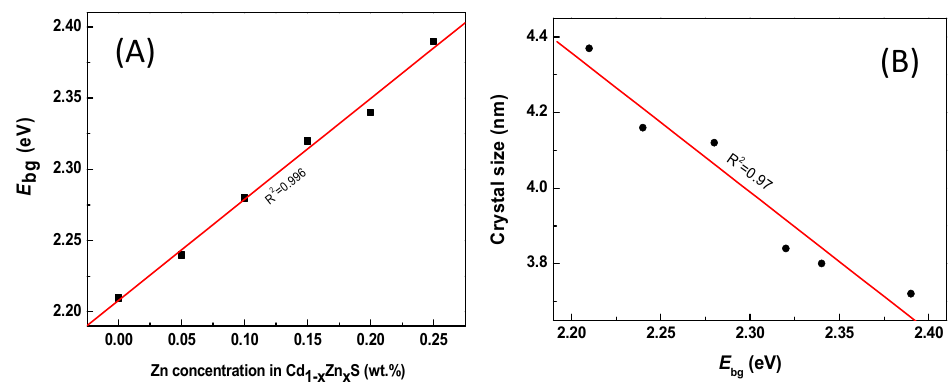
Figure 11. Energy band gap against Zn concentration in solution ( A ) and the correlation between the crystal size (from XRD) and E bg ( B ).